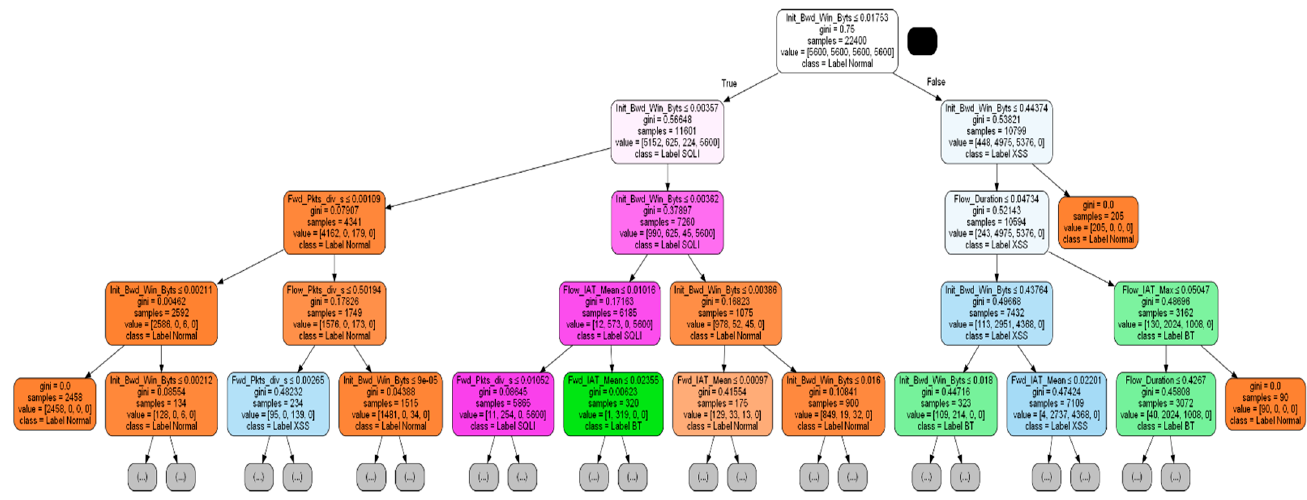
Figure 6. Decision Tree